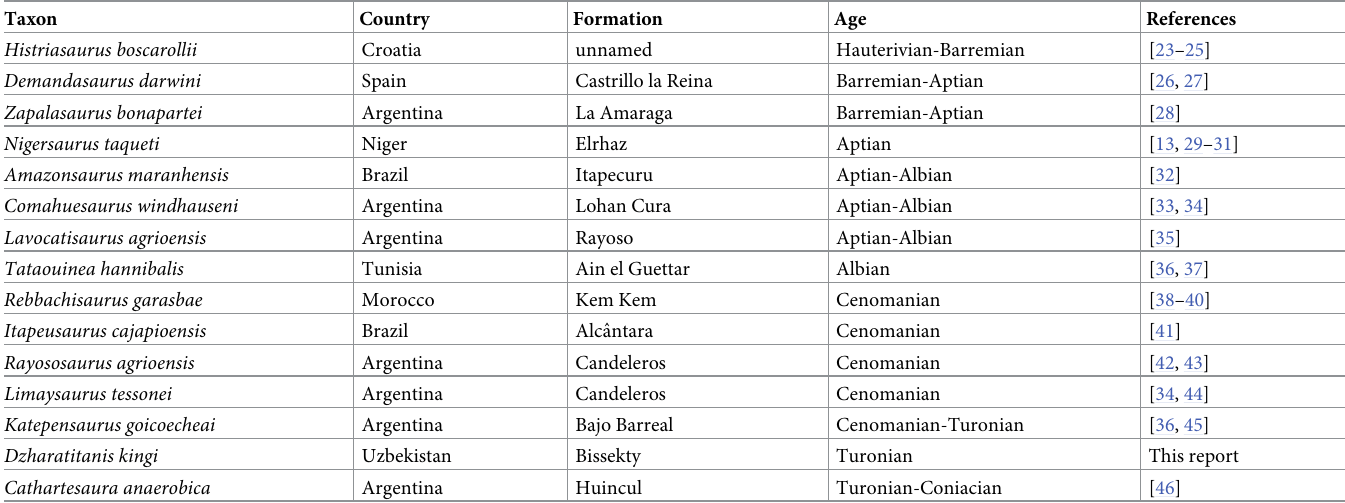
Table 1. Spatial and temporal distribution of the Rebbachisauridae.